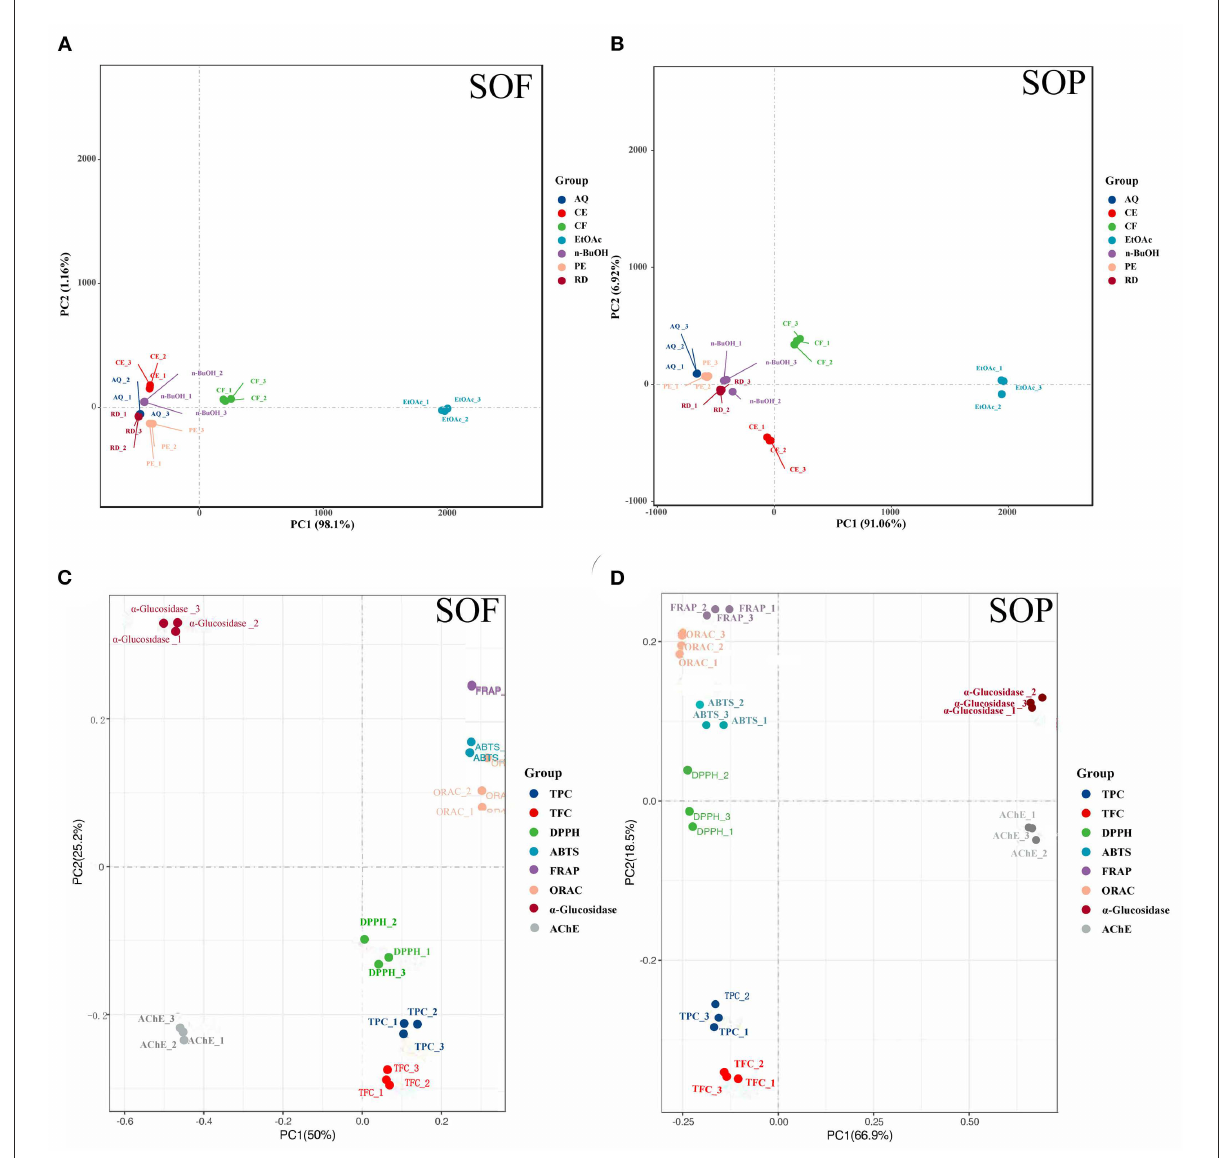
FIGURE3 Principal component analysis (PCA) of different samples and indicators. (A,B) PCA of seven SOEs and fractions; (C,D) principal co-ordinates analysis (PCoA) of eight indicators of active ingredient content and biological activity; SOEs, Stauntonia obovatifoliola extracts; SOF, Stauntonia obovatifoliola flesh; SOP, Stauntonia obovatifoliola pericarp. CE, crude extract; PE, Petroleum ether fraction; CF, chloroform fraction; EtOAc, ethyl acetate fraction; n-BuOH, n-Butanol fraction; AQ, aqueous phase residue; RD, residue; TPC, total phenolic content; TFC, total